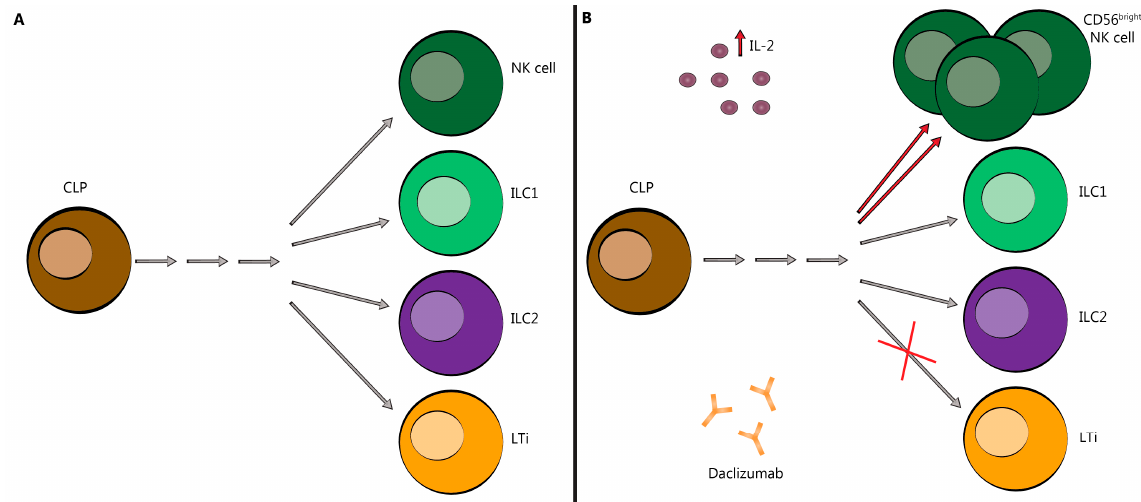
Figure 3. Innate Lymphoid Cells skewed toward CD56 bright NK cells following DAC treatment. ( A ) DAC binds to CD25 blocking association with CD132 and CD122. This prevents trans-presentation of CD25 from mDC to T cells and results in effector T cell and T reg cell death. ( B ) As a result of CD25 blockade, serum IL-2 levels are elevated allowing for NK cell activation through the intermediate-affinity receptor, CD132 and CD122, and promoting CD56 bright NK cell cytotoxicity and survival (red arrows). It may also redirect the commitment of LTi cells (red × ). CLP-common lymphoid progenitor; NK-natural killer; ILC-innate lymphoid cell; LTi-lymphoid tissue-inducer cell; IL-2-interleukin-2. Grey arrows indicate a series of differentiation steps not depicted in this figure.